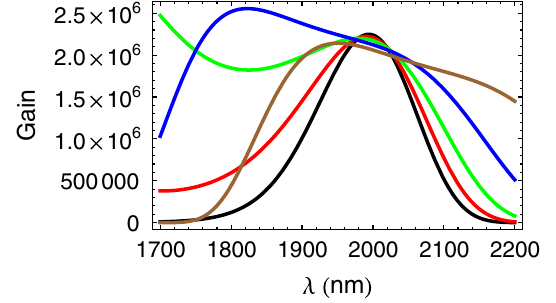
FIG. 7. Calculated Fourier-transform-limited normalized pulse shape before (black) and after (red) OPCPA. The total gain length in BBO is 7.5 mm, and the OPCPA is pumped by 10 GW = cm 2 800 nm pulses. Injection of a 41 fs seed pulse results in a 50 fs amplified pulse.